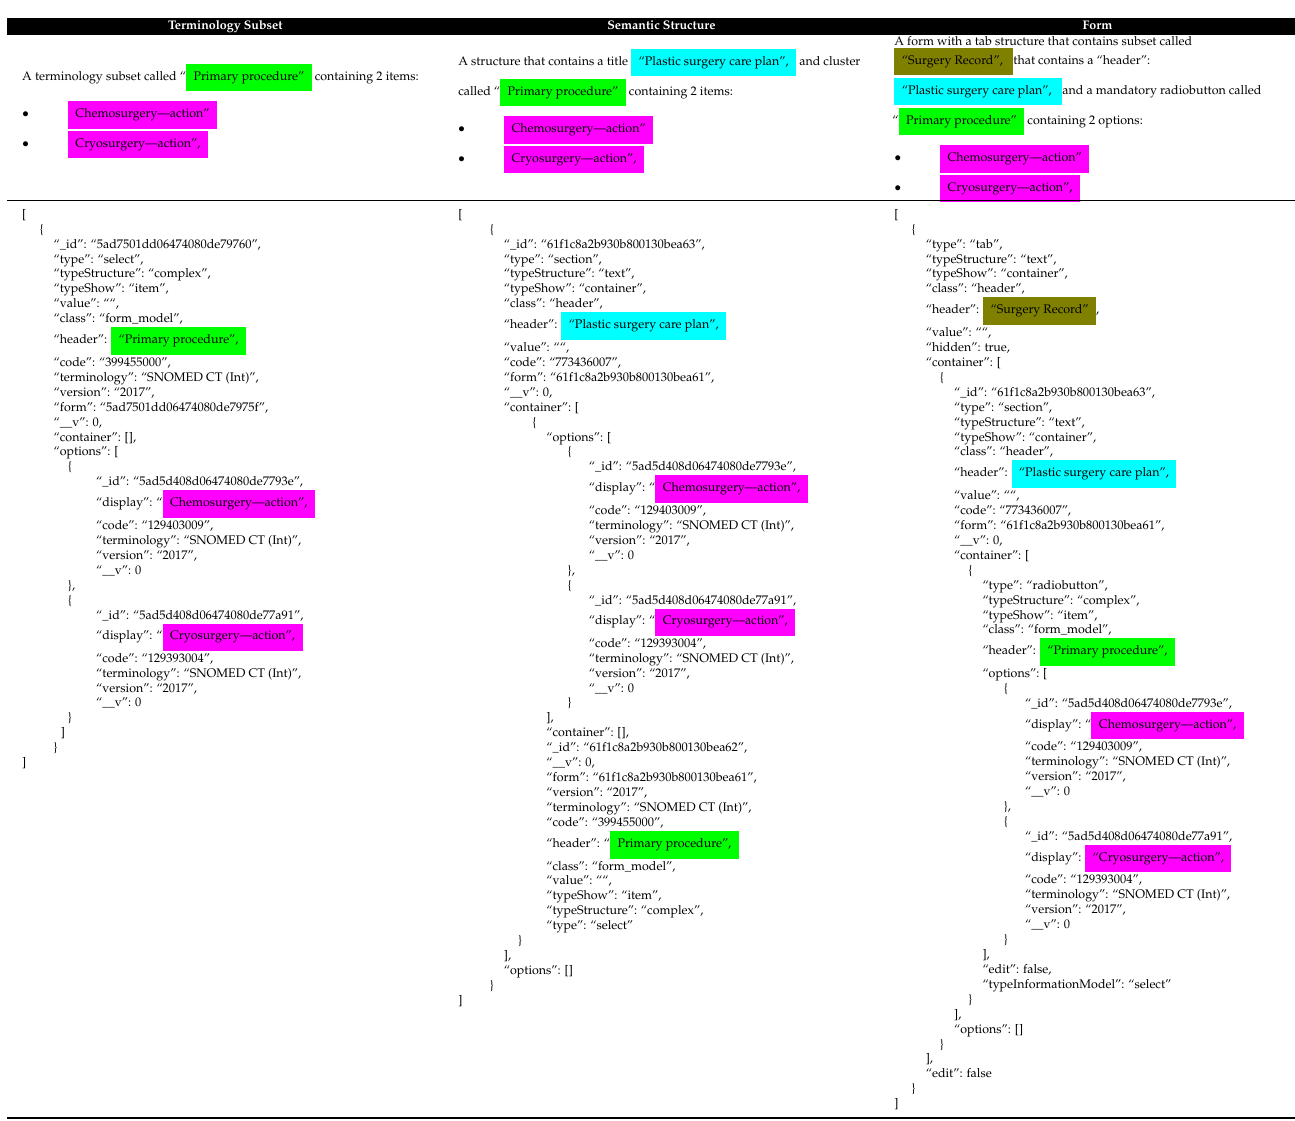
Table A3. Example of MedicalForm JSON for terminology subsets, semantic structures and